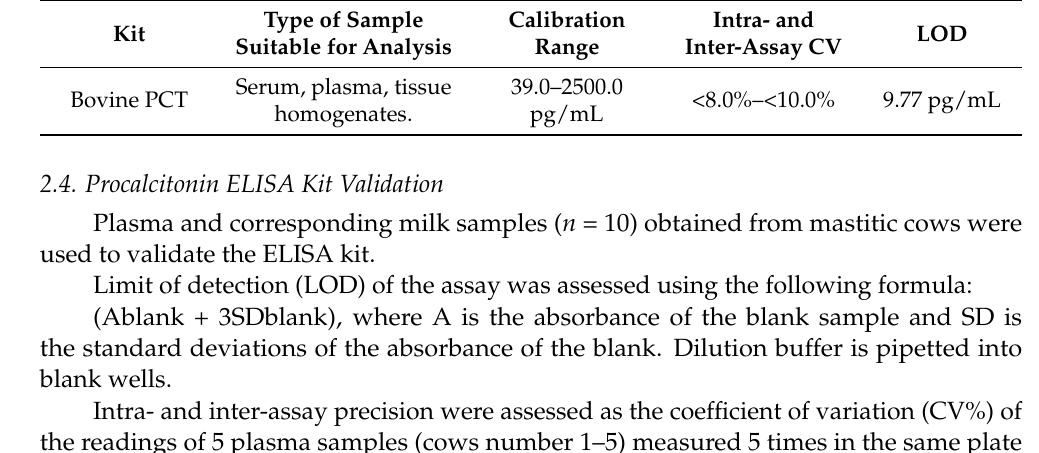
Table 1. Performance characteristics of studied kit. Legend: CV—coefficient of variation; LOD—limit of detection. Type of Sample Kit Suitable for Analysis Serum, plasma, tissue Bovine PCT homogenates.